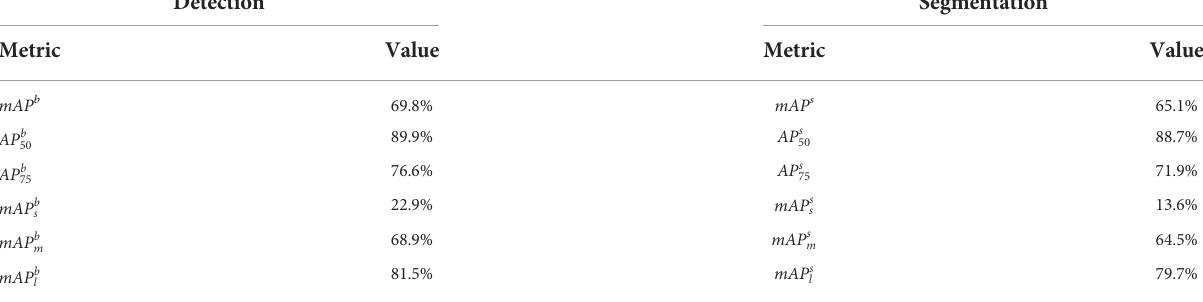
TABLE 2 Accuracy of detection and segmentation under the data